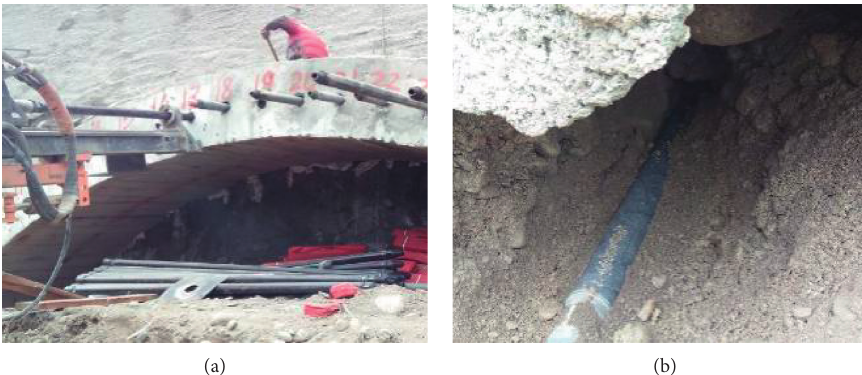
Figure 5: Construction drawings of left-line inlet pipe shed. (a) Pipe shed construction drawings. (b) Borehole localization.